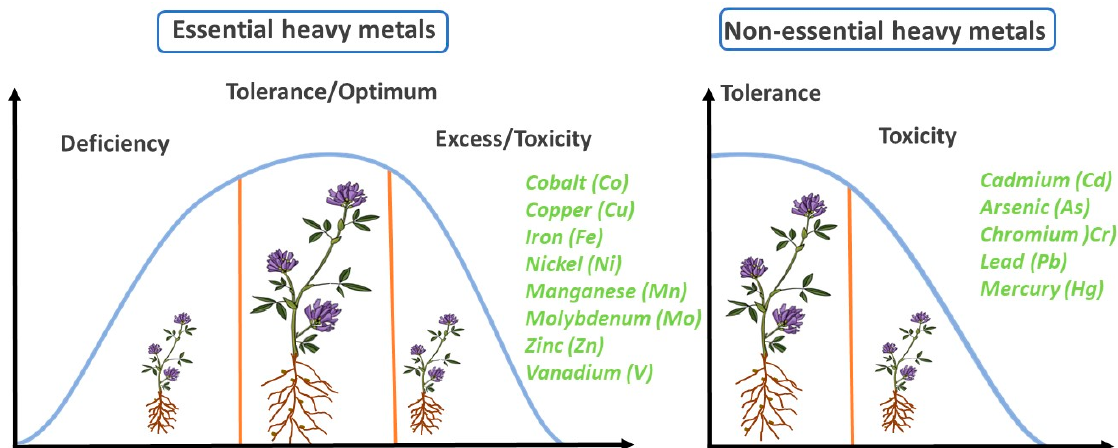
Figure 2. Mode of action of essential and non-essential heavy metals.